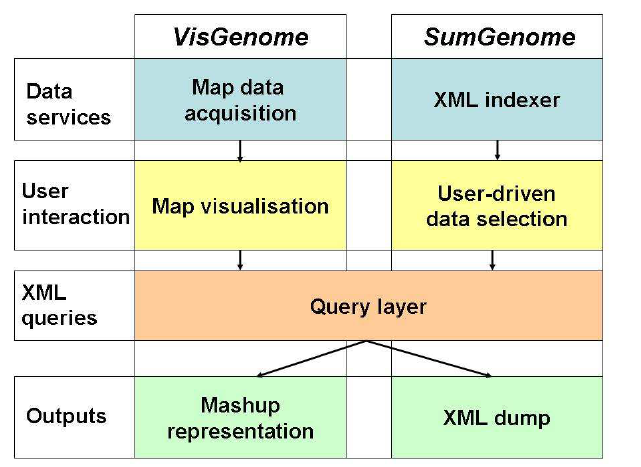
Figure 8: BioXMash is composed of VisGenome and SumGenome. Both applications provide a data service, a user interaction component, and generate outputs. They use a shared XML data integration component which performs